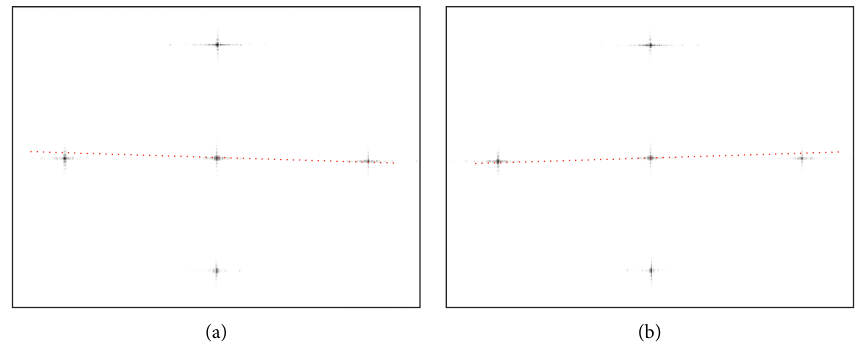
Figure 2: The last two subimages reconstructed by modified FFBP. (a) Subimage 1. (b) Subimage